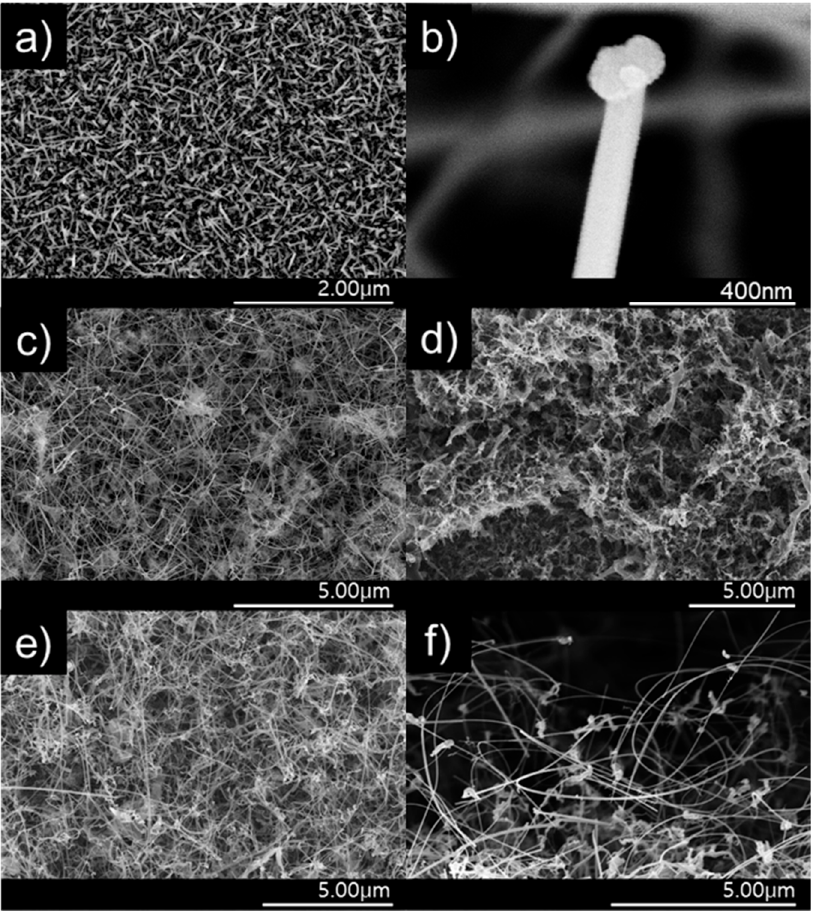
Figure 6. Field emission scanning electron microscopy (FE-SEM) images of ( a ) ZnO NWs, ( b ) the tip of an NW, ( c ) NW vines, ( d ) NW vines decorated with 0.1 M α -Fe 2 O 3 , ( e ) NW vines decorated with 0.05 M α -Fe 2 O 3 , and ( f ) side view of the NW vines decorated with 0.05 M α -Fe 2 O 3 .